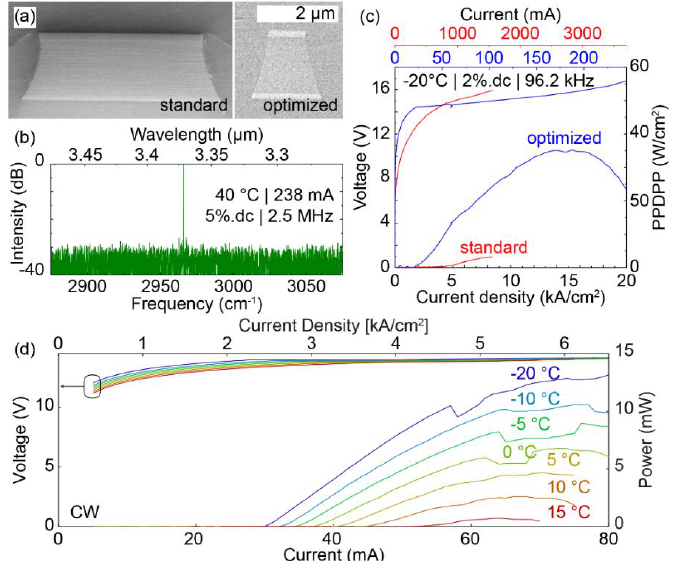
Figure 6. Summary of results for short-wavelength QCLs operating in the 3–3.5 µm range. ( a ) SEM micrographs depicting facets of devices fabricated following the standard and optimized process